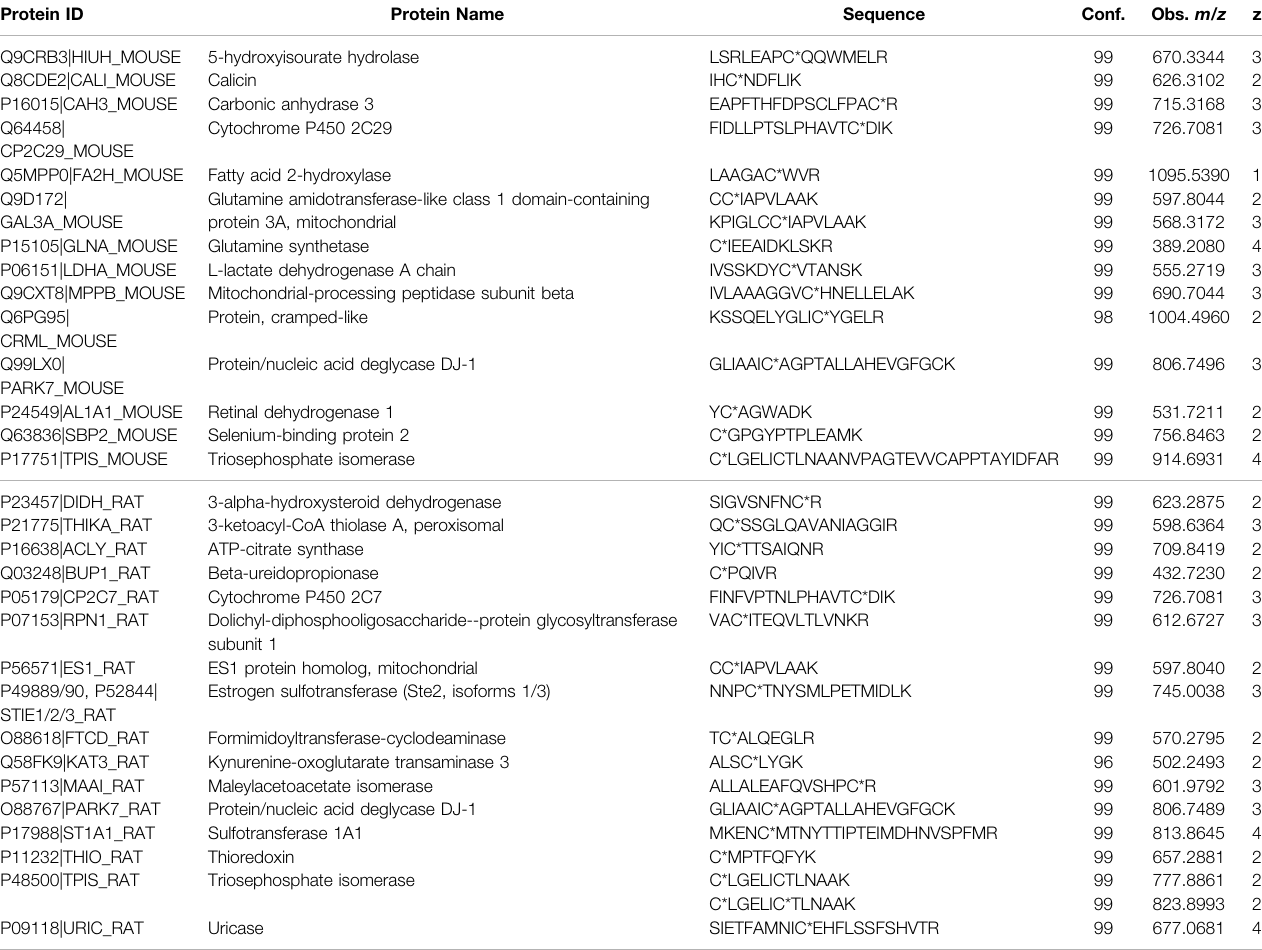
TABLE 1 | APAP-modi fi ed peptides in rat and mouse liver identi fi ed by data-dependent high-resolution MS/MS. Protein ID Protein